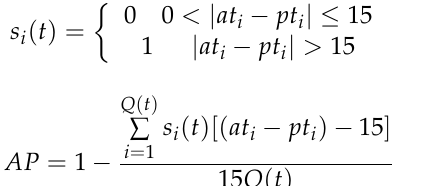
Table 6. Multi-FGHP performance evaluation value for different flights at the current moment. Flight